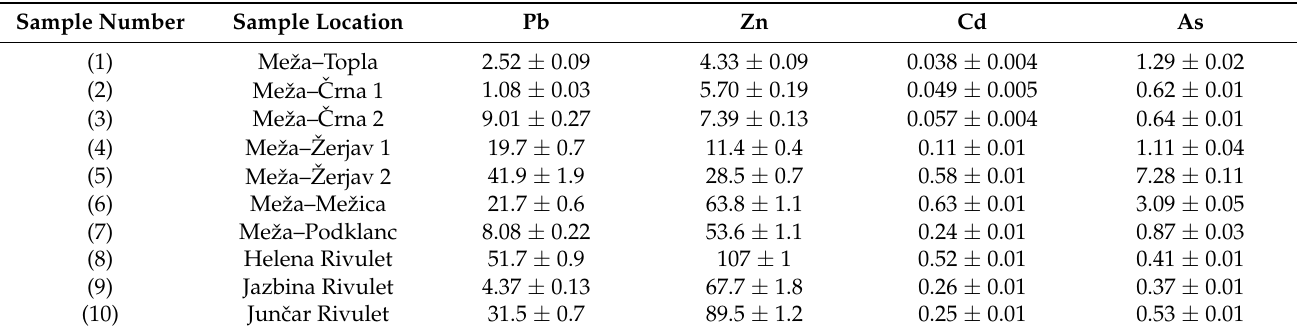
Table 1. Total concentration of Pb, Zn, Cd and As ( µ g/L) in water samples from the Meža River and its tributaries determined by ICP-MS. Results are expressed with standard